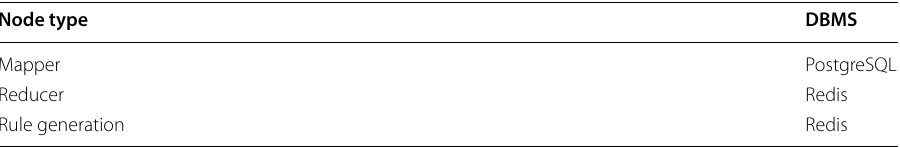
Table 10 DBMS for the various node